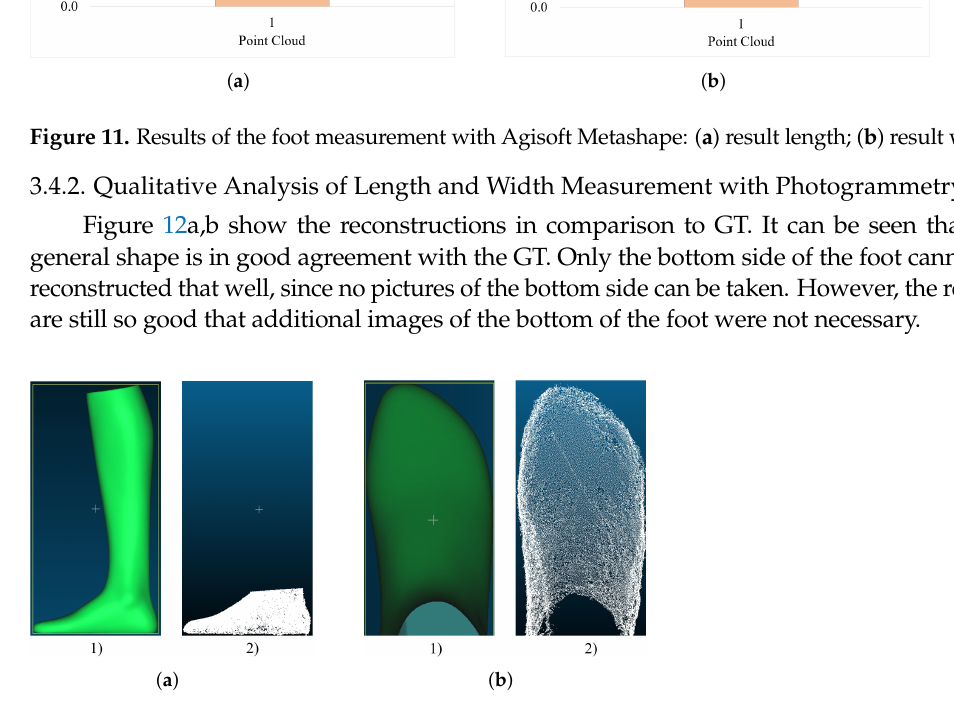
Figure 12. Results of the reconstructed foot with Agisoft Metashape Photogrammetry Software: ( a ) point cloud of the foot model generated for length measurement: (1) GT; (2) Agisoft Metashape; ( b ) point cloud of the foot model generated for width measurement: (1) GT; (2) Agisoft